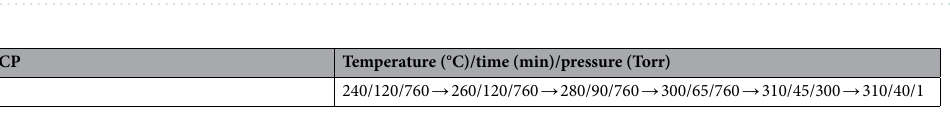
Table 1. Melt polymerization conditions of TLCPs.